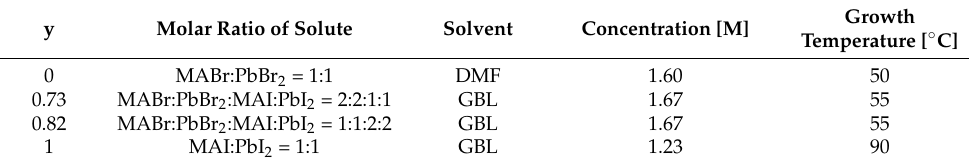
Table 1. Growth conditions of MAPb(Br 1 − y I y ) 3 crystals with varied I